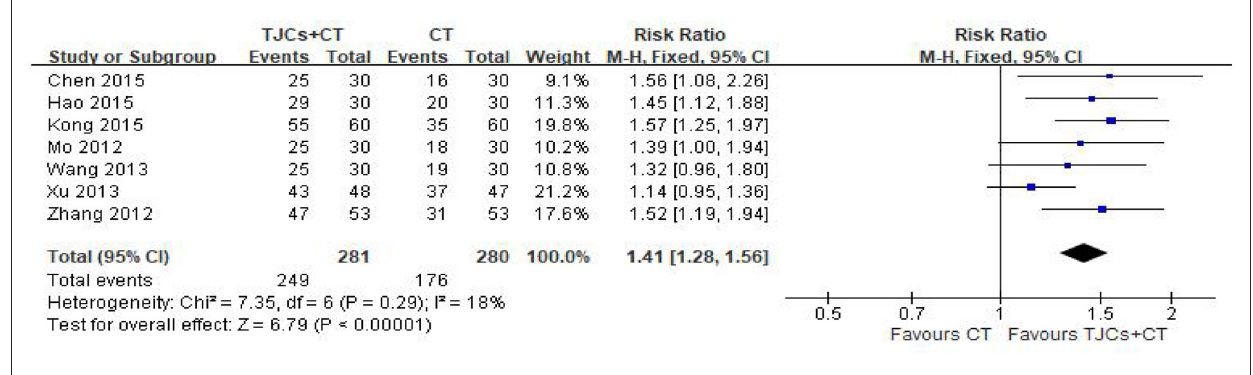
FIGURE7 Forest plot of total effective rate.